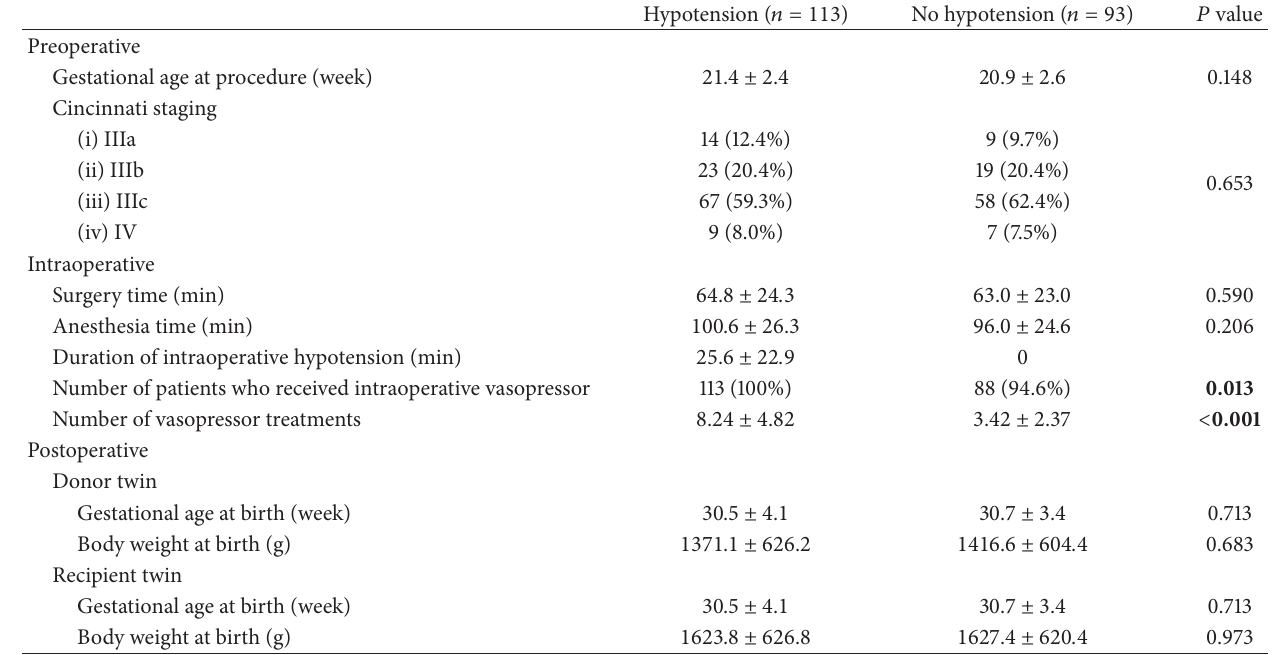
Table 3: Perioperative characteristics of patients with and without intraoperative hypotension. Intraoperative hypotension is defined as maternal systolic blood pressure below 80% of baseline and an absolute value less than 90mmHg. Only nifedipine exposure patients were included to minimize confounder. The Cincinnati staging system, which integrates the severity of cardiomyopathy into IIIa (mild cardiomyopathy), IIIb (moderate cardiomyopathy), IIIc (severe cardiomyopathy), and IV (hydrops), was used to compare the severity of TTTS in this study.